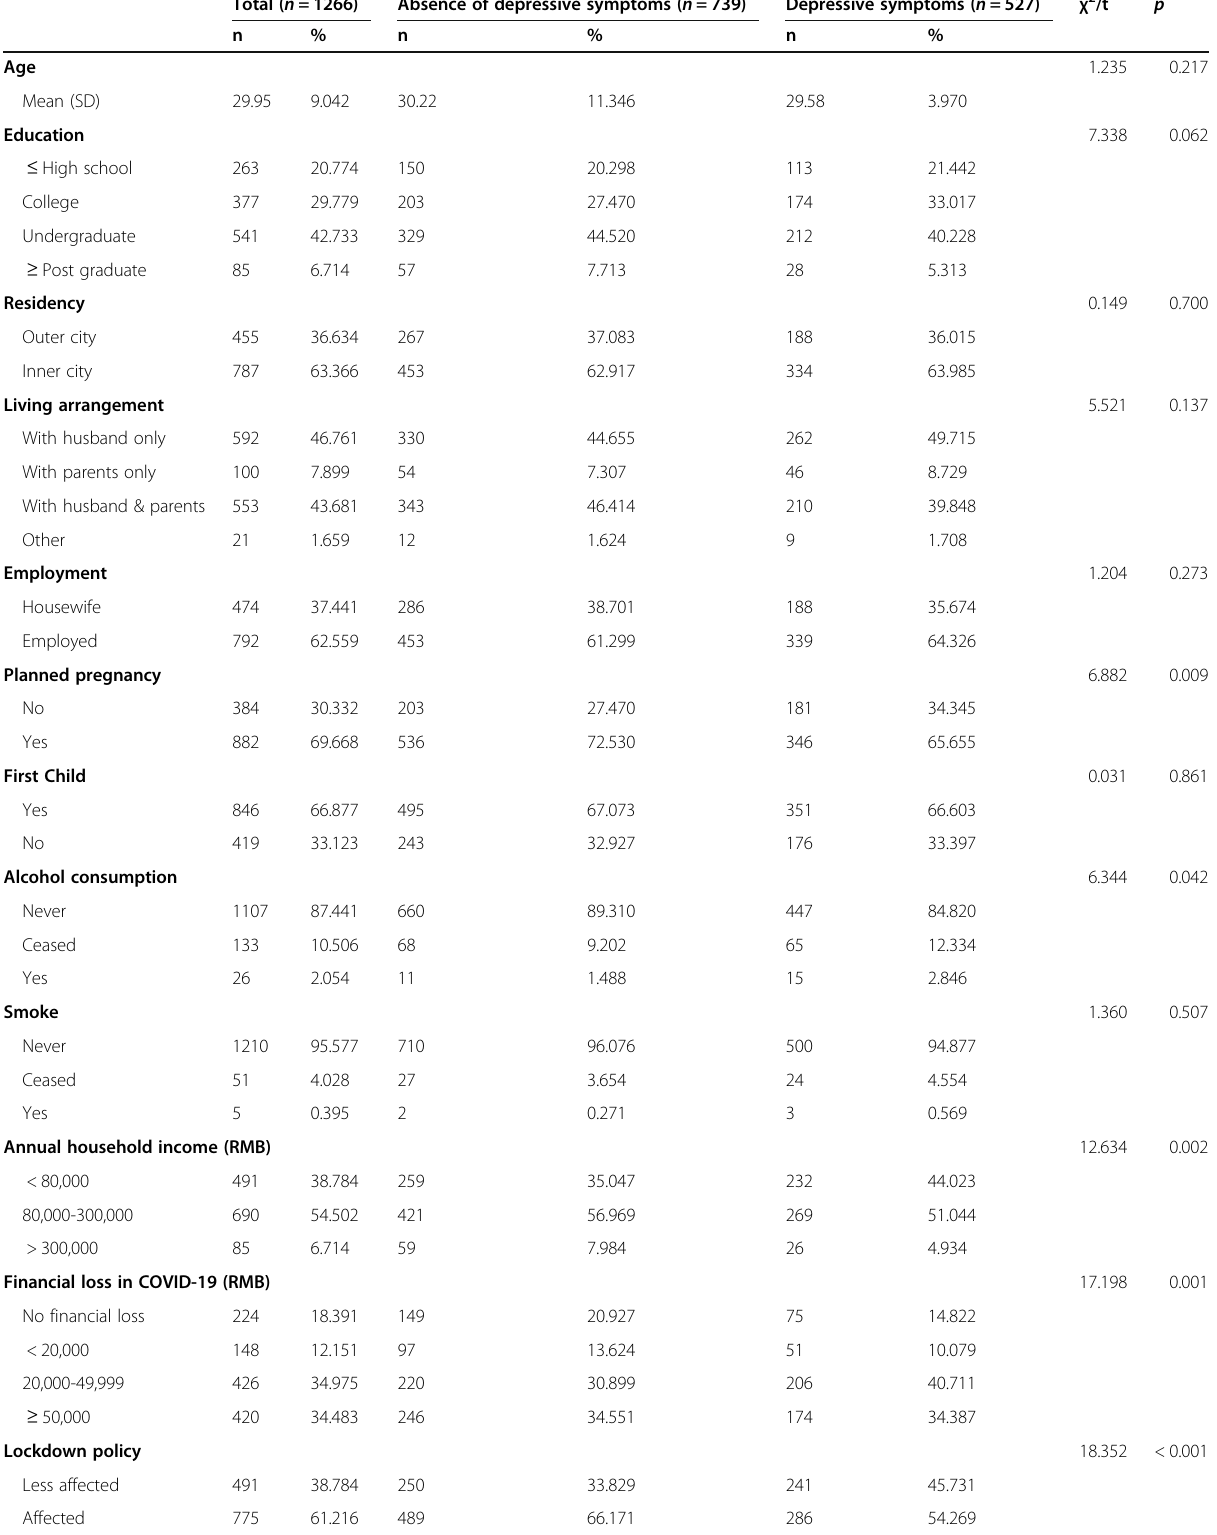
Table 1 Basic characteristics of the